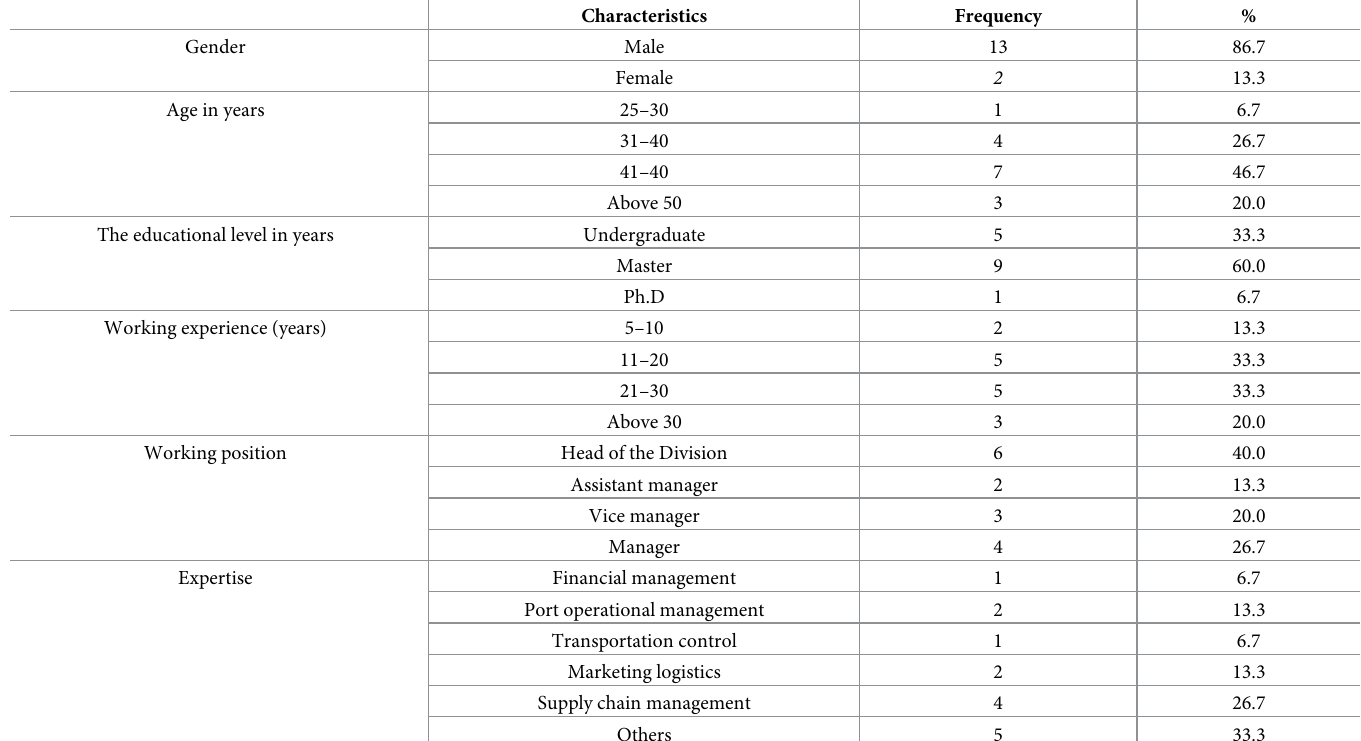
Table 4. Respondents’ characteristics.